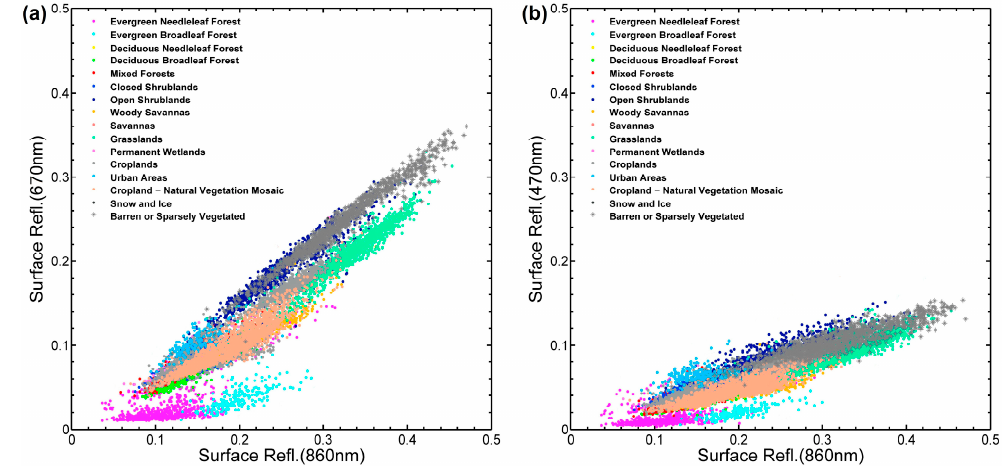
Figure 2. MODIS-derived spectral surface reflectance relationship between 0.67 and 0.86 µm ( a ) and between 0.47 and 0.86 µm ( b ) during autumn 2008, as a function of surface types from MCD12C1 data.